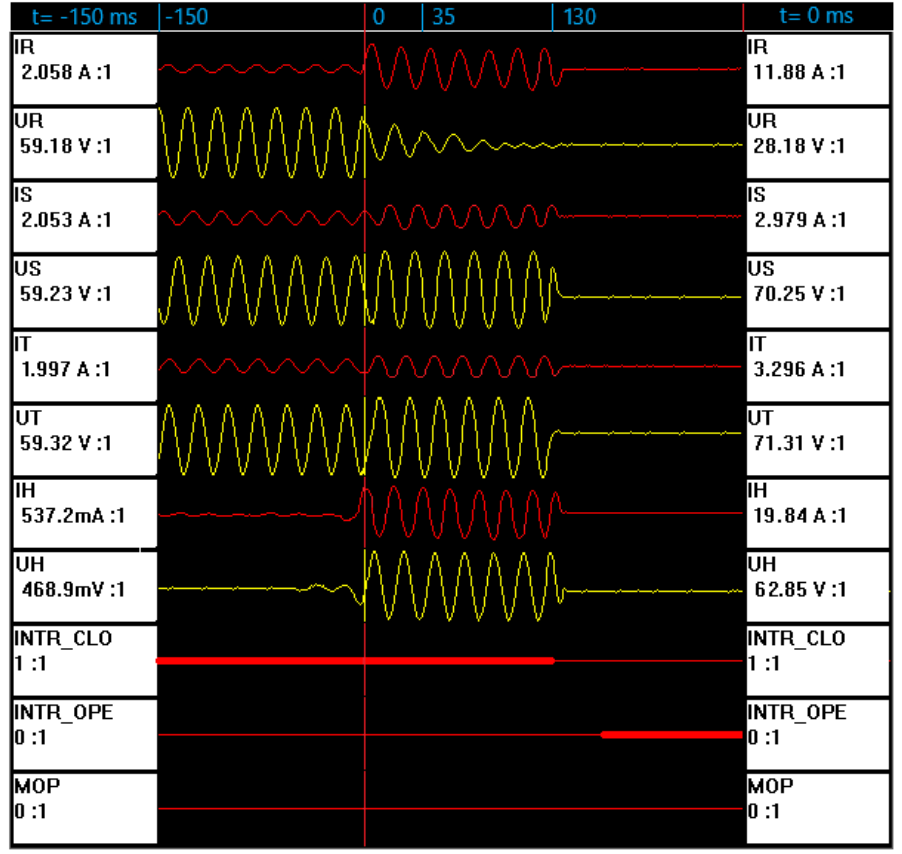
Figure 11. The oscillogram of the monitored parameters when the fault occurs.